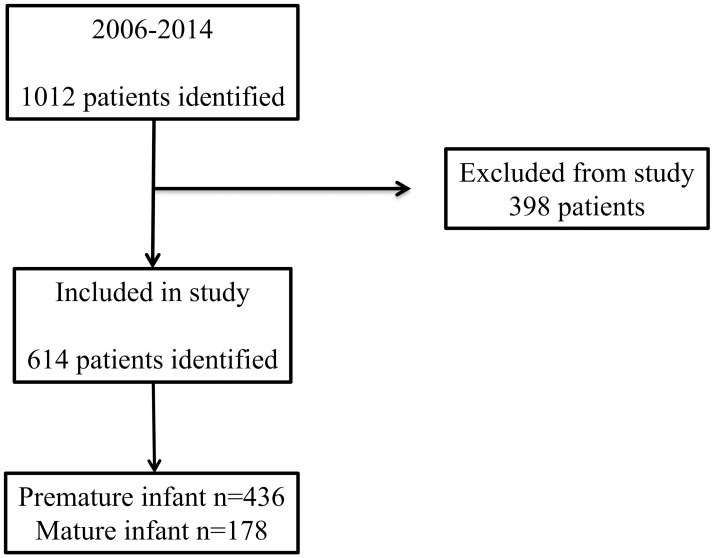
Flowchart of subjects in this study.